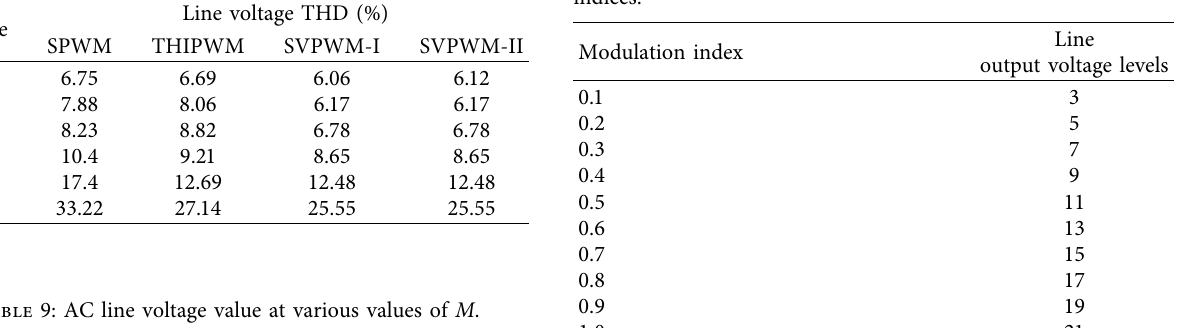
Table 10: Line output voltage levels for diferent modulation